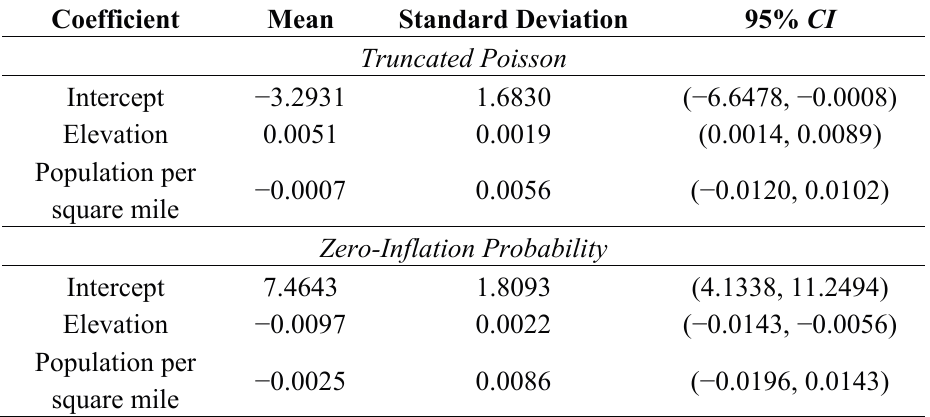
Table 2. Model results for the spatial Poisson hurdle model (with regression for